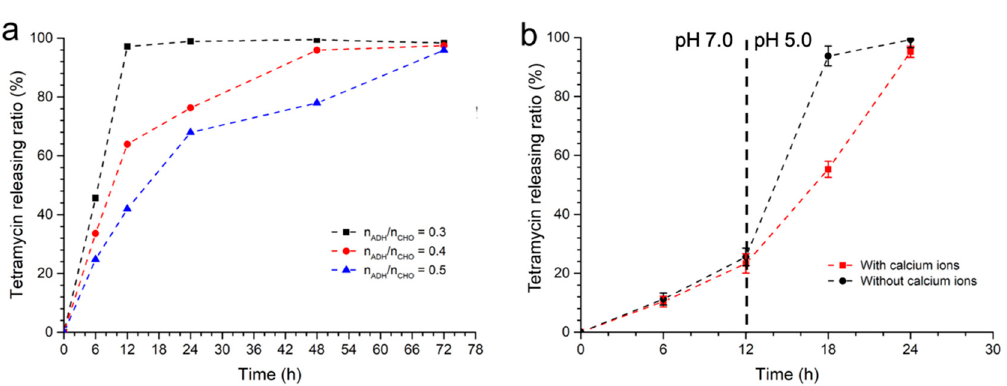
Figure 4. ( a ) The tetramycin releasing rate of the gel with different ADH amounts under pH 5. ( b ) The change of tetramycin releasing rate when the gel was fabricated with or without Ca 2+ . n ADH and n CHO are the molar quantity of ADH and the total CHO group in the gel, respectively.